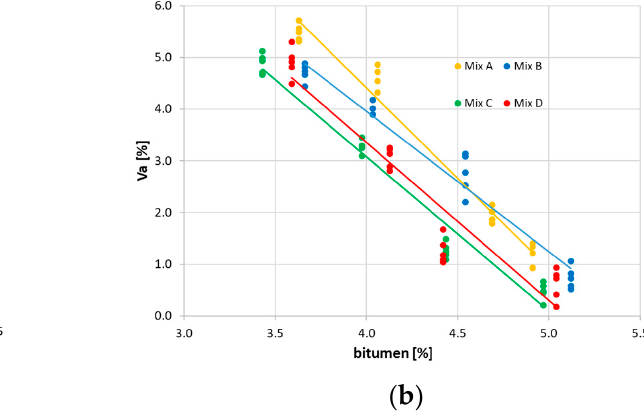
Figure 3. Air voids content. ( a ) MijM; ( b ) MijG.